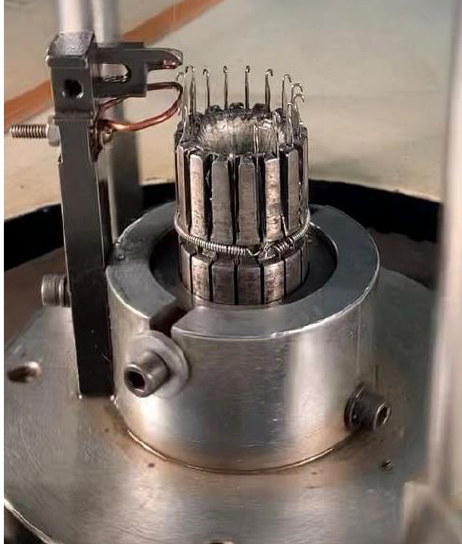
Figure 1. Wire knitting machine WK-150 for circular knitting.